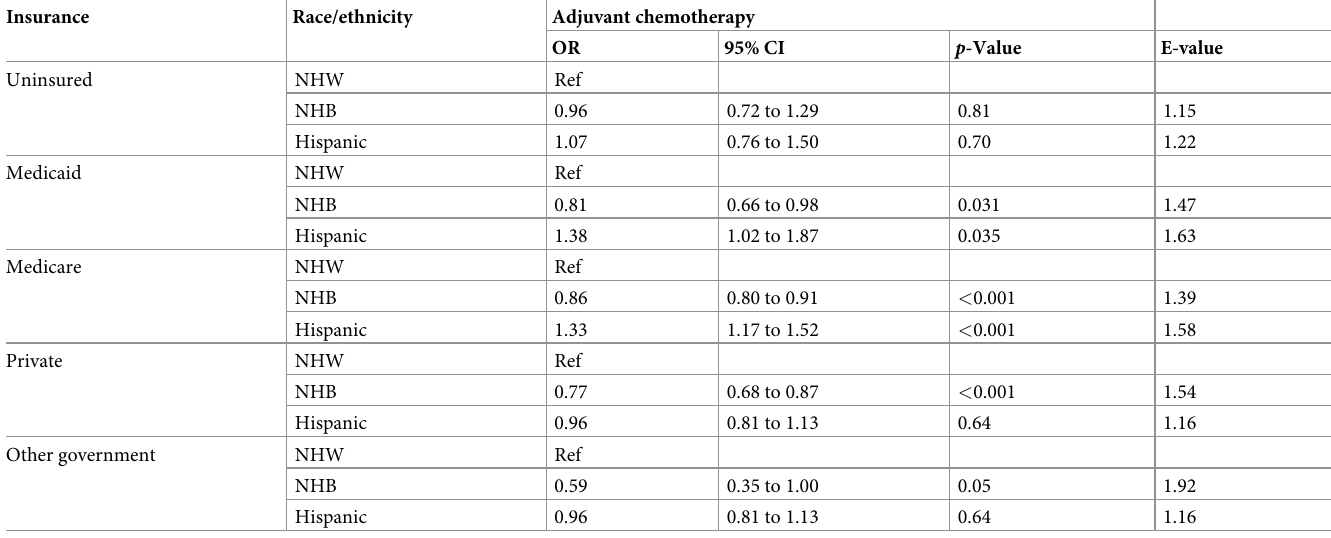
Table 6. Effect modification of insurance on race/ethnicity and adjuvant chemotherapy.